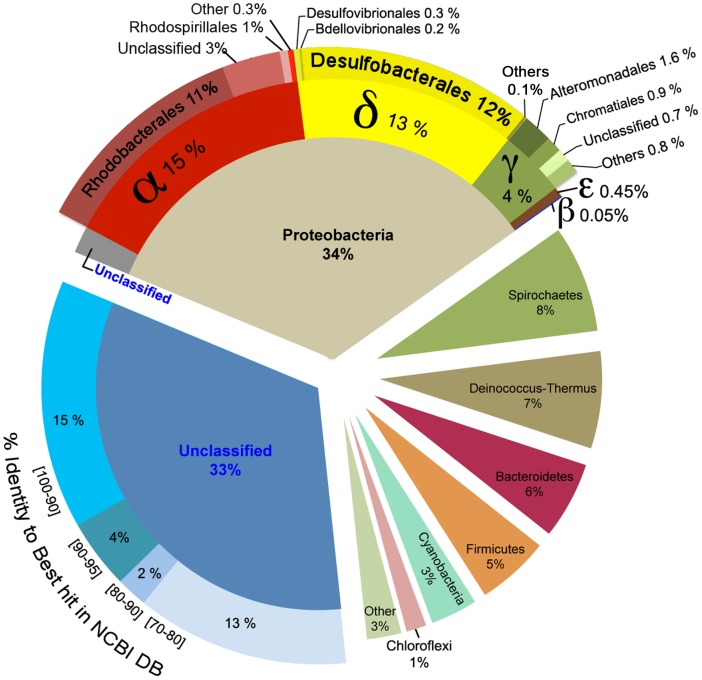
Taxonomic composition of Bacteria in the Socompa stromatolites derived from the detected 16S pyrotags.The unclassified sequences at phylum level were analysed by BLAST against the full NCBI database, and grouped according to the percentage identity to the best hit.